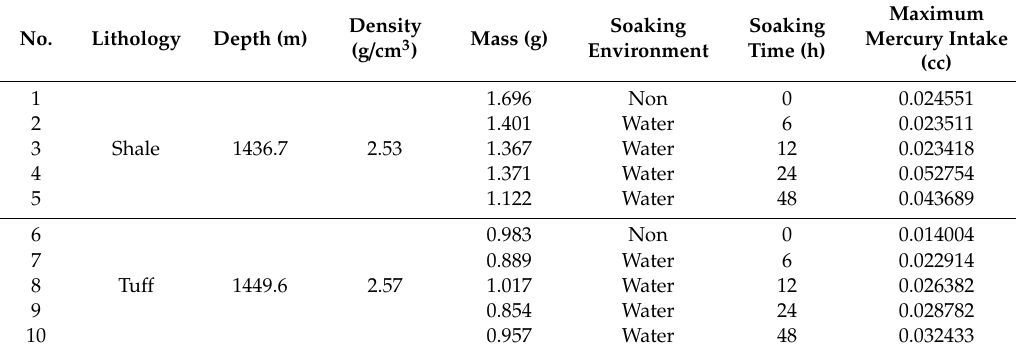
Table 3. Mercury porosimetry test sample